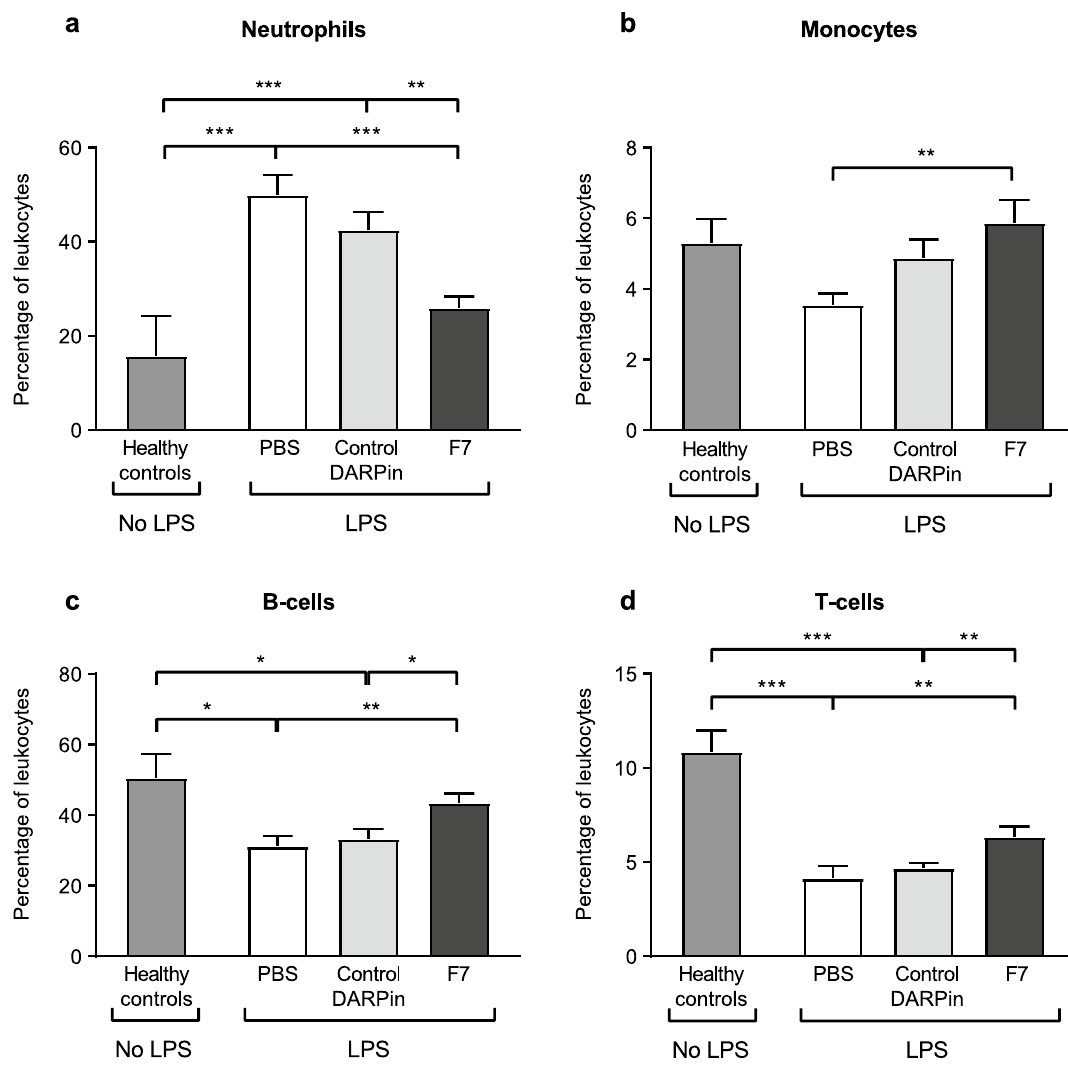
Figure 3. Flow cytometric analysis of blood leukocytes during the acute phase. Blood was harvested and leukocyte staining for flow cytometry was performed as described in the “Methods” section. The percentage of all leukocytes is presented. ( a ) The percentage of blood neutrophils was lower in the group treated with F7 compared to PBS or the control DARPin. ( b ) The percentage of monocytes was increased in the group treated with F7. ( c ) The percentage of B-cells was also increased in the group treated with F7 compared to PBS and control DARPin and similar to the healthy controls. ( d ) A similar observation was made for the percentage of T-cells in blood. Data are presented as mean ± SEM. n = 5–19, * p < 0.05, ** p < 0.01, *** p < 0.001. Treatment groups were compared by an unpaired